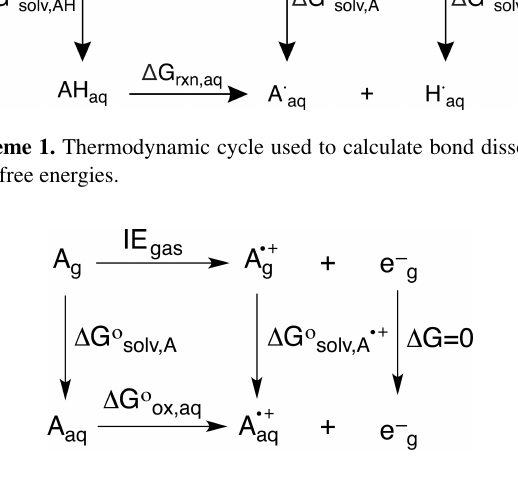
Scheme 2. Thermodynamic cycle used to calculate oxidation po-